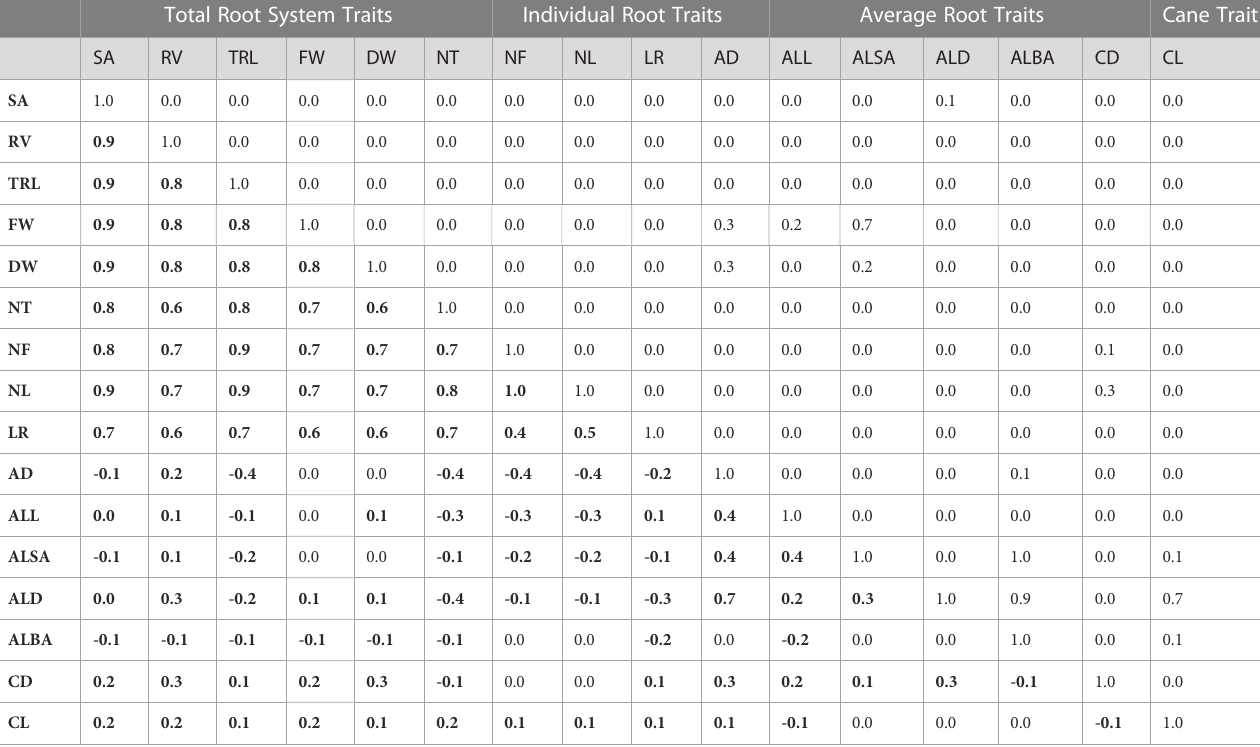
TABLE 3 Pearson correlation coef fi cients for RSA traits in VRS-F 2. . Total Root System Traits Individual Root